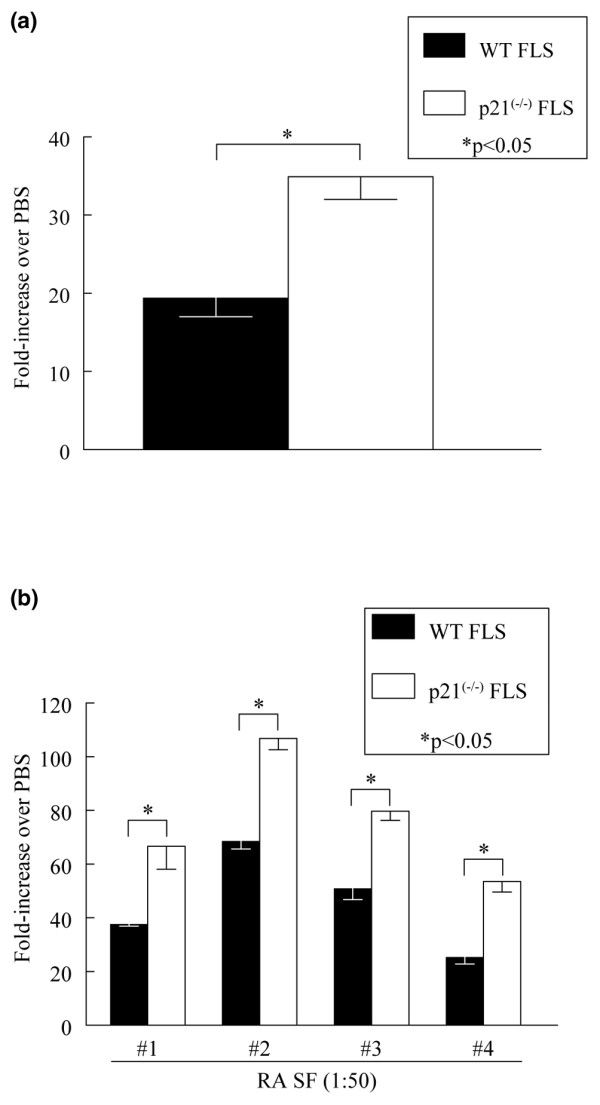
p21(-/-) fibroblast-like synoviocytes (FLS) migrate more than wild-type (WT) FLS in response to rheumatoid arthritis (RA) synovial fluid (SF). WT and p21(-/-) FLS were introduced to gradients of RA SFs (diluted in PBS) to induce migration. Cell counts are expressed as fold-increase over background migration to PBS (negative control). (a) Combined chemotaxis data analyzed from four separate patients in three independent experiments demonstrates significantly more migration by the p21(-/-) FLS compared with WT FLS (p < 0.05). (b) Representative data from 1 of 3 independent chemotaxis assays performed using RA SF diluted 1:50 from 4 separate patients randomly designated #1 to #4. p21(-/-) FLS migrated significantly (indicated by an asterisk) more than WT cells in response to all four RA SFs tested.